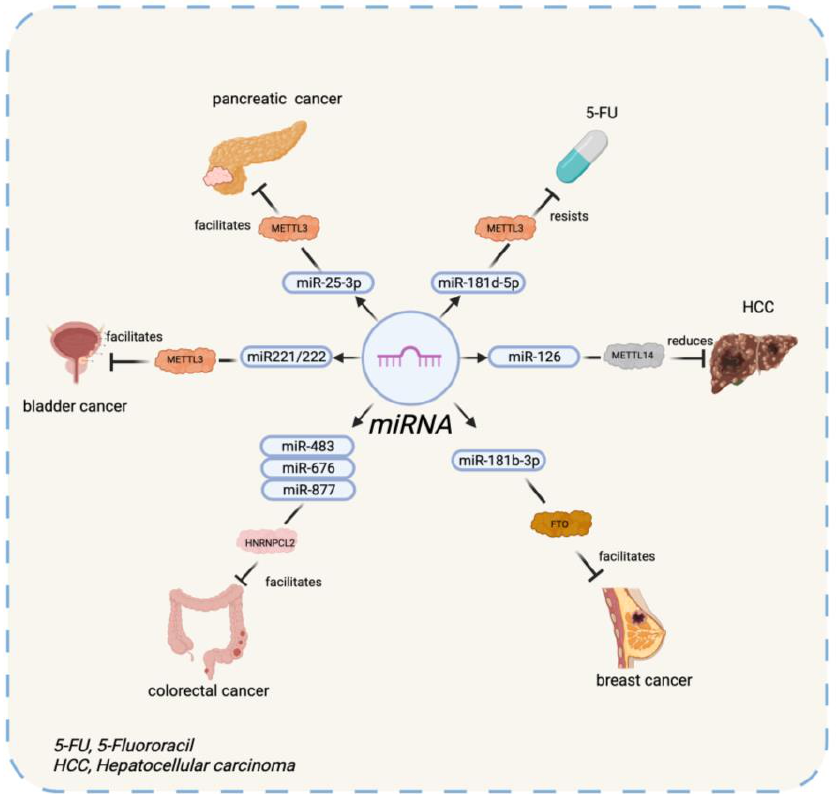
Figure 1. The interaction between miRNA and its m6A regulators.